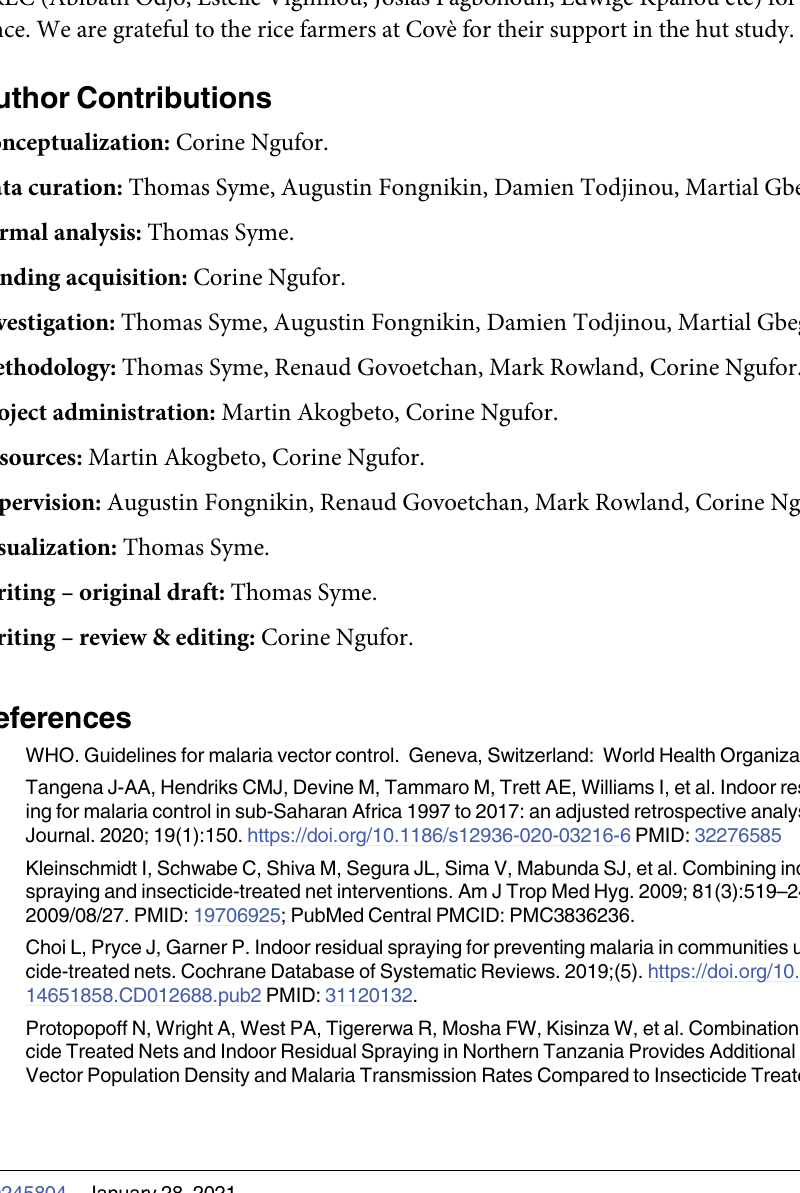
S1 Table. Overall experimental hut results with wild free-flying pyrethroid resistant An